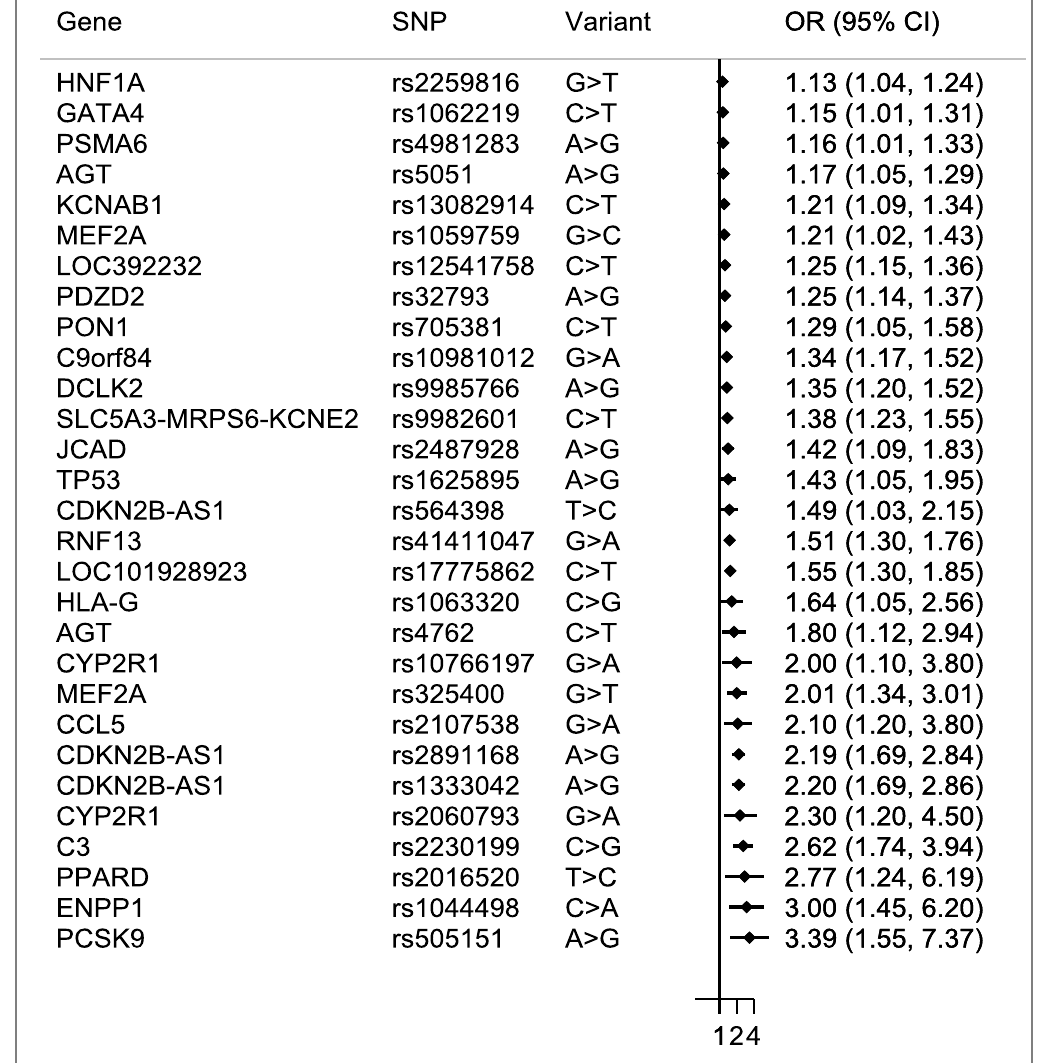
Figure 5. Summary of the OR (95% CI) for the 29 variants ineligible for inclusion in the meta-analysis. Single observations which were not meta-analyzed are presented in the Figure. The ORs ranged from 1.13 to 3.39, with a median of 1.49 (interquartile range